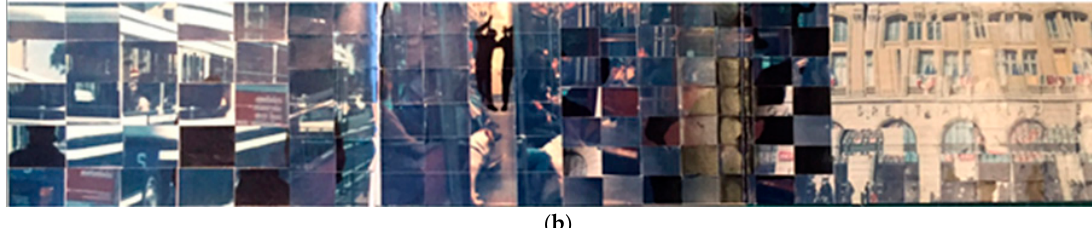
Figure 6. Exercises in Style, texticule: ( a ) Parachesis, ( b ) Permutations by Groups of 5, 6, 7, and 8